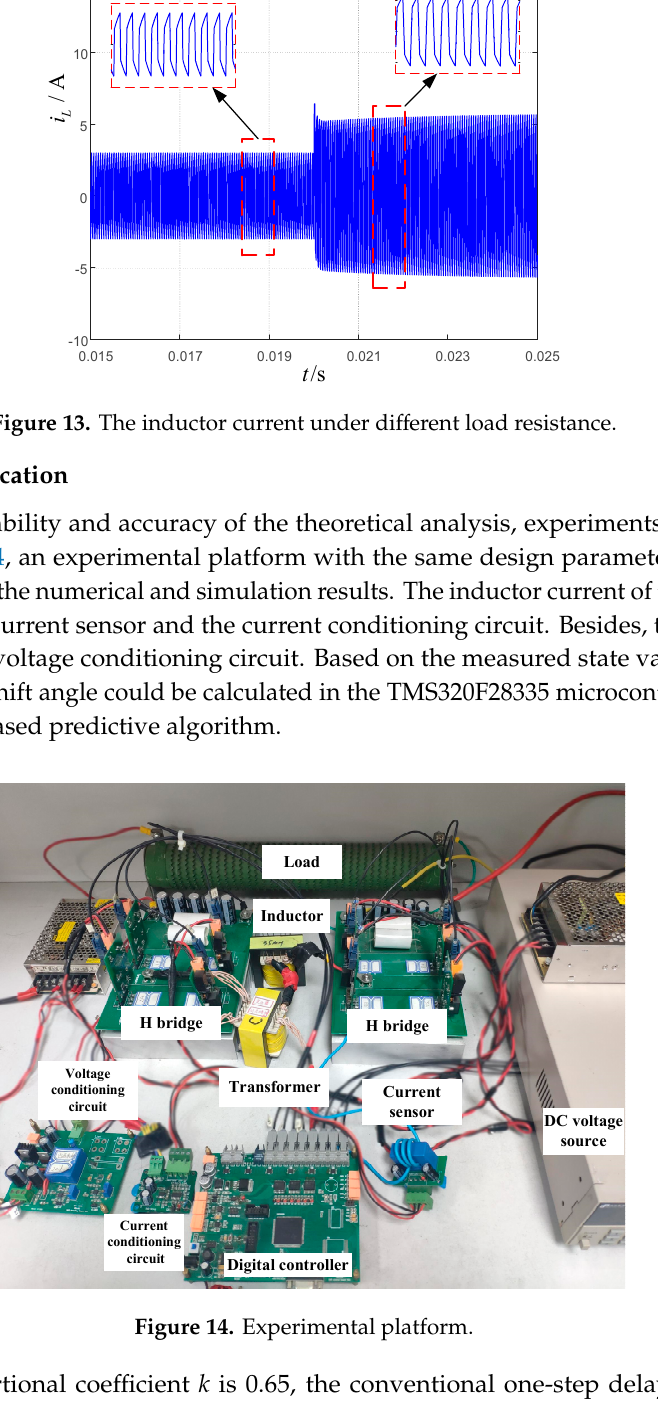
Figure 14. Experimental platform